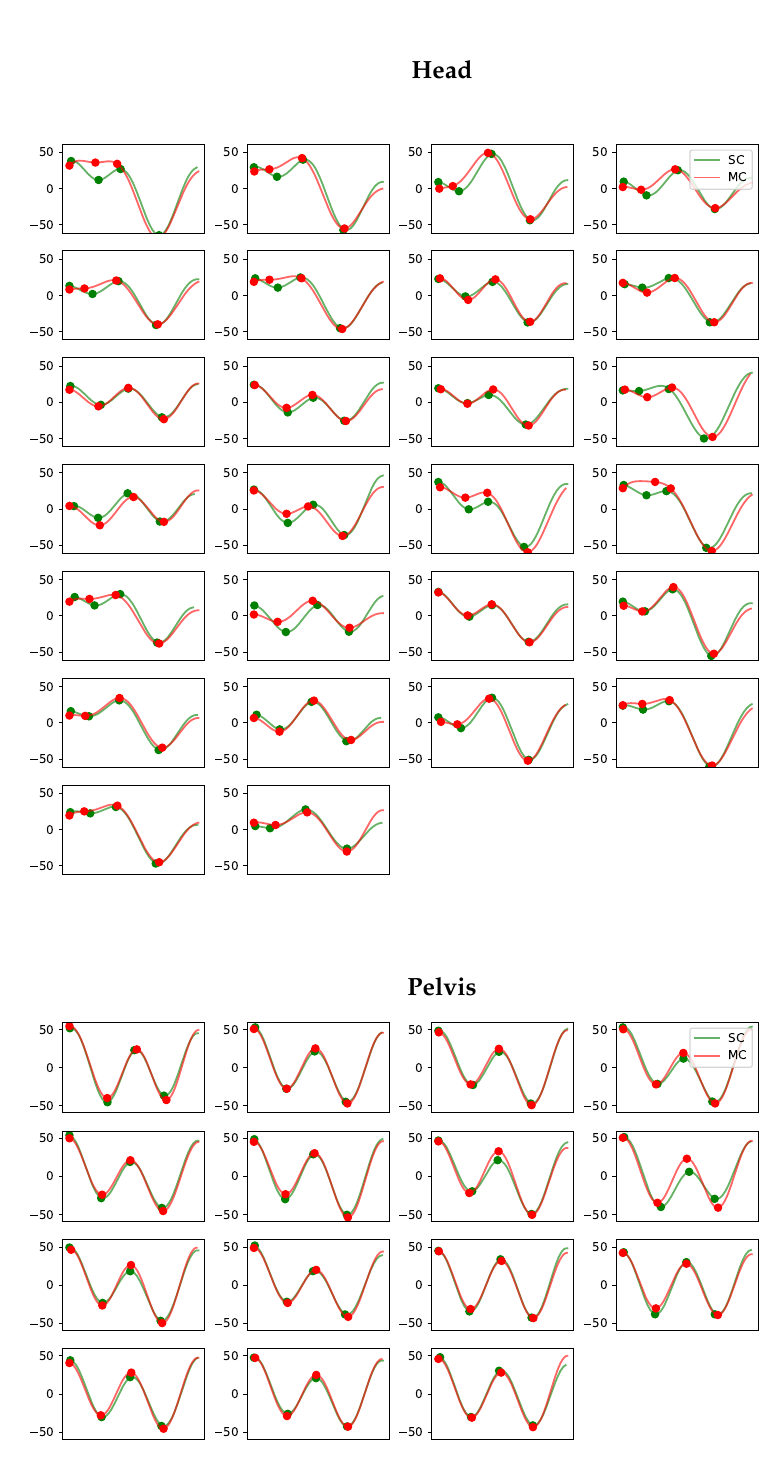
Figure A6. Vertical displacement signals per stride for the head and pelvis for horse 6. Each subplot contains the matched stride segments for the single-camera markerless system (SC) in green and the multi-camera marker-based system (MC) in red. The y-axis shows the vertical displacement in millimeters. The four dots on each curve indicate the positions of the two peaks and two valleys extracted using the approach in Section